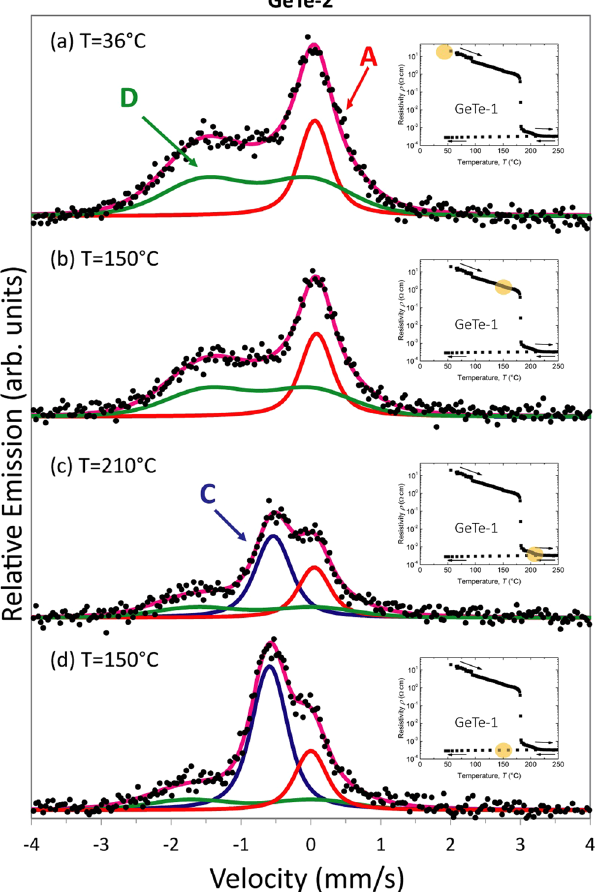
Figure 3. 57 Fe emission Mössbauer spectra obtained on the GeTe-2 held at the temperatures indicated. The purple solid line is the sum of the Lorentzian A and C single lines and the Voigt lineshape quadrupole-doublet D. The insets show the corresponding resistivity state as measured in GeTe-1.